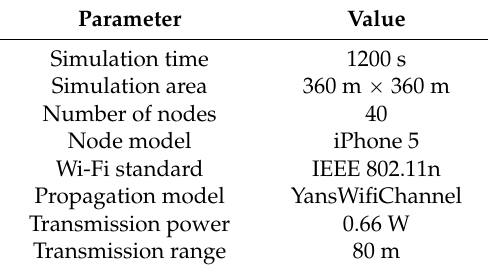
Table 2. Simulation general